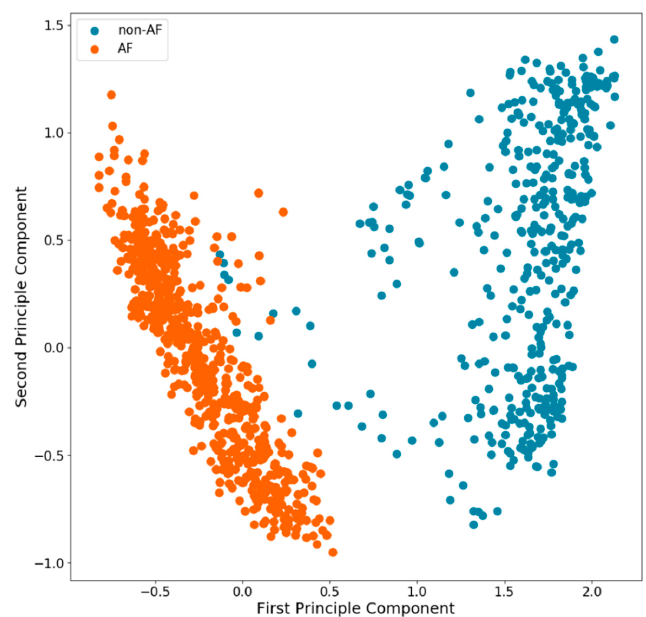
Figure 3. First two principle components of the latent space from the unsupervised Deep Learning approach for five-minute periods. Results of one-nearest neighbor classification for individual periods are shown that would be interpreted as AF (orange) or non-AF (blue).